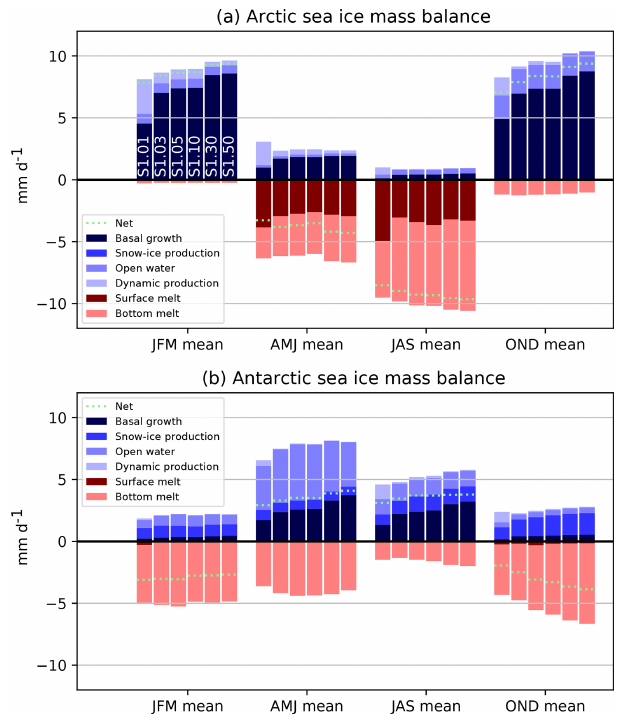
Figure 4. Contributions to the seasonal mass balance of Arctic (a) and Antarctic (b) sea ice as simulated in the first set of sensitivity ex- periments (S1) (varying number of categories with the default LIM3 ITD discretization), averaged over the areas depicted in Fig. A1. Blue colors refer to processes that contribute to positive ice volume changes, while red colors indicate processes implying negative ice volume changes. The name of the experiments is indicated in the upper panel for the January–February–March